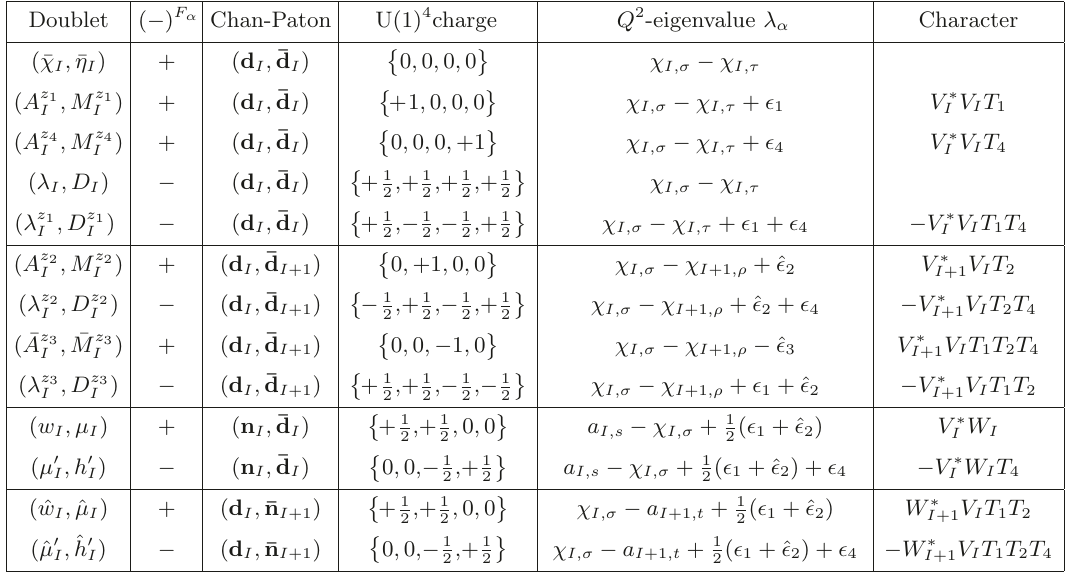
Table 1 . The spectrum of moduli, organized in doublets of the BRST charge Q (or its conjugate ¯ Q ). For each of them, we display their statistics ( ) F α , the representation of the color and ADHM groups − in which they transform, their charge vector with respect to the U(1) 4 symmetry, the eigenvalue λ α of Q 2 and the corresponding contribution to the character. The neutral moduli carrying a superscript z 1 , z 2 , z 3 or z 4 , and the colored moduli in this table are complex. The